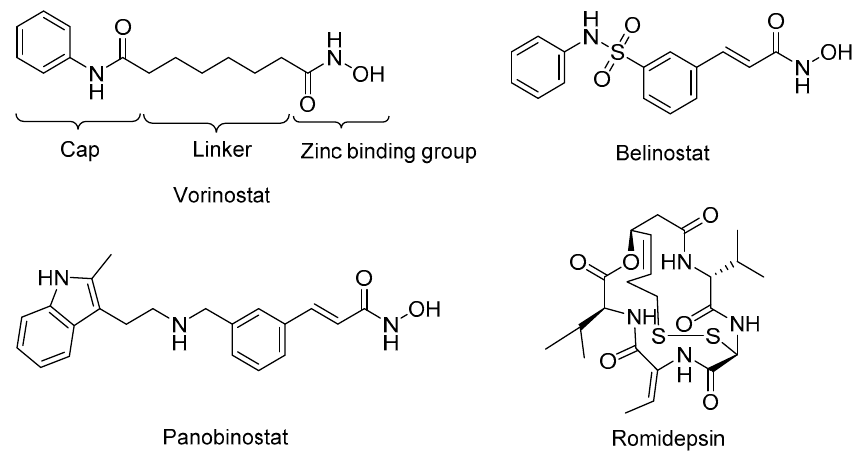
Figure 2. Chemical structures of HDAC inhibitors that are FDAapproved for use in cancer therapy.